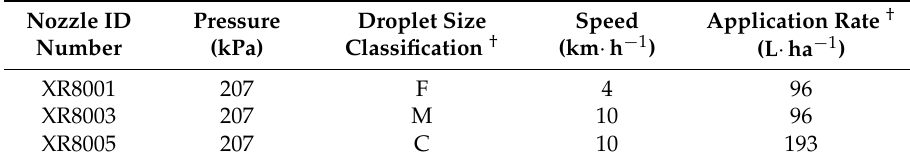
Table 2. TeeJet nozzles used in spray chamber testing with corresponding pressure, droplet size classification, application speed and